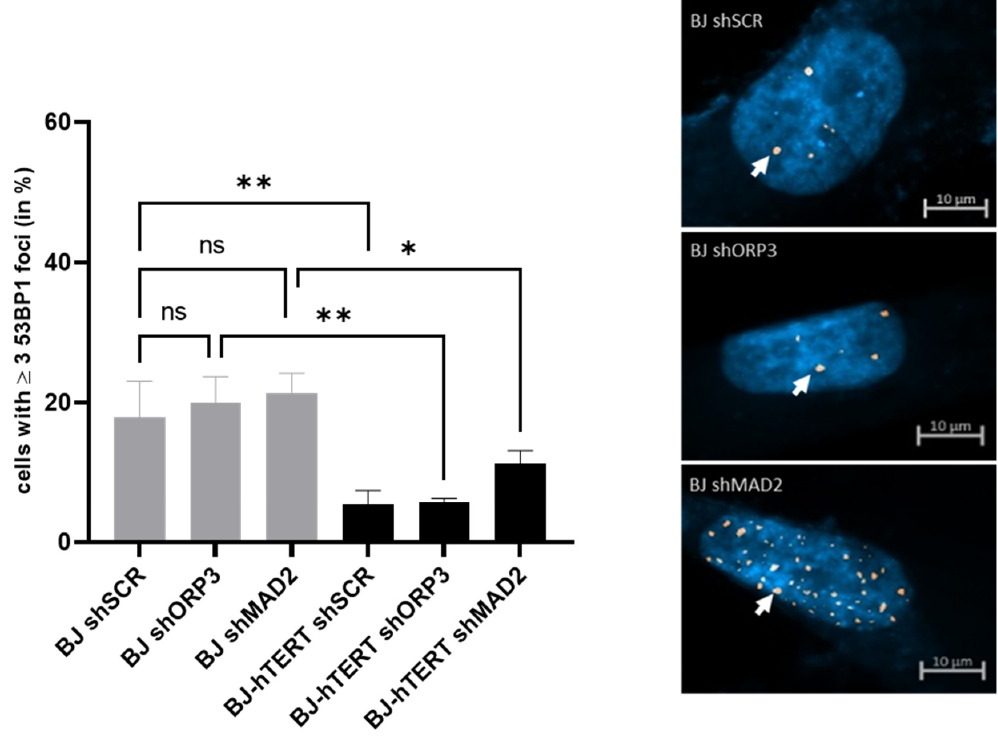
Figure 8. Evaluation of 53BP1 foci formation upon aneuploidy-induced replication stress. ( Left ) The bar plot displays the impact of ORP3 or MAD2 downregulation on 53BP1 foci formation in BJ and BJ-hTERT cells. pGIPZ-shSCR was used as an shRNA control vector. One-way ANOVA test was applied, followed by a Fisher’s LSD post hoc test, with a confidence interval of 95%. ( Right ) Representative images from BJ-shSCR (top), BJ-shORP3 (middle), and BJ-shMAD2 (bottom) cells. A total of 300 cells were counted from n = 6 independent experiments. The representative pictures show DAPI-stained nuclei with nuclear pRPA2 foci (white arrow). ns ( p > 0.05), * ( p ≤ 0.05), ** ( p ≤ 0.01).